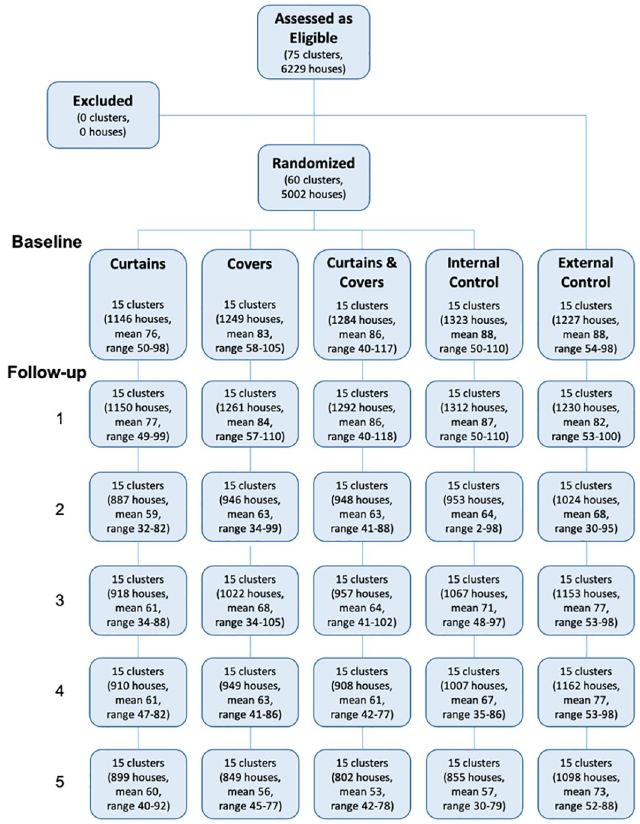
Fig 3. CONSORT flowchart showing the recruitment and allocation of houses to the study arms and retention over time.